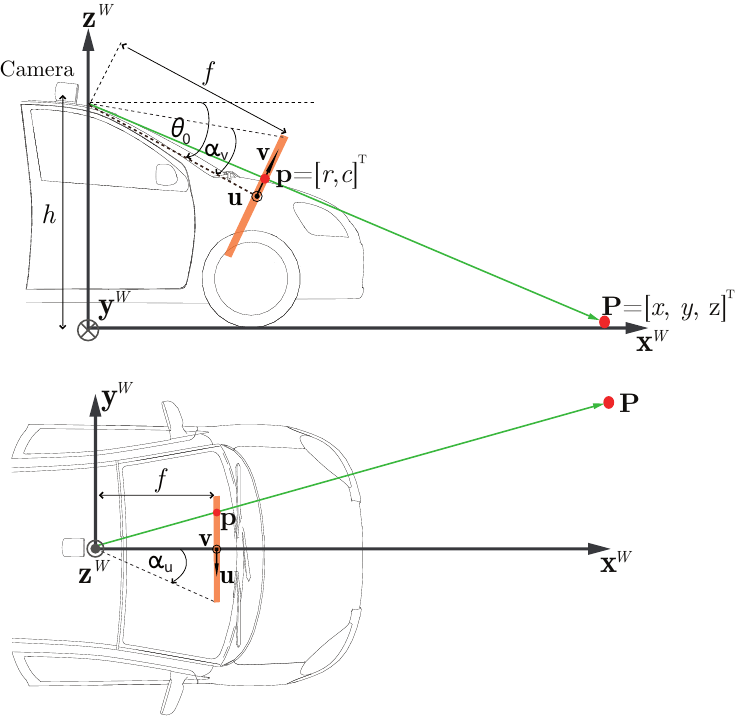
Figure 4. Inverse perspective projection model: point p on the optical plane is projected back onto point P on the